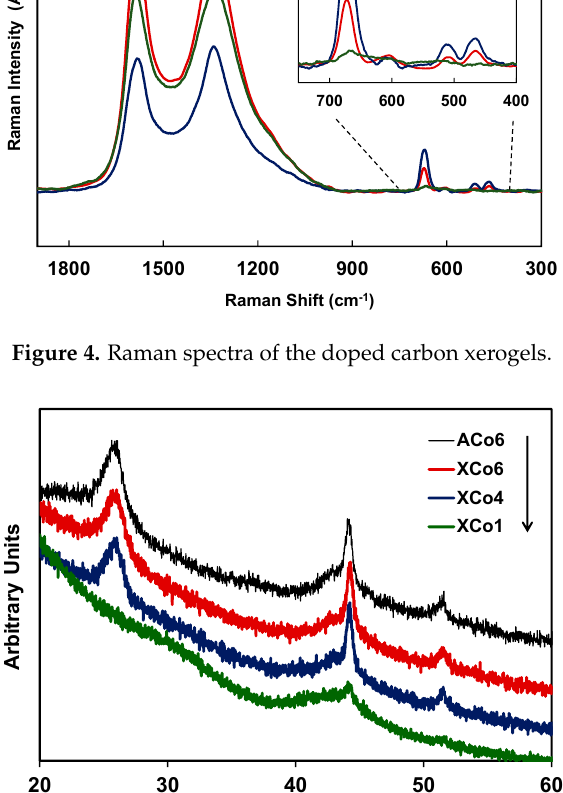
Figure 5. XRD patterns of samples ACo6, XCo6, XCo4, and XCo1.